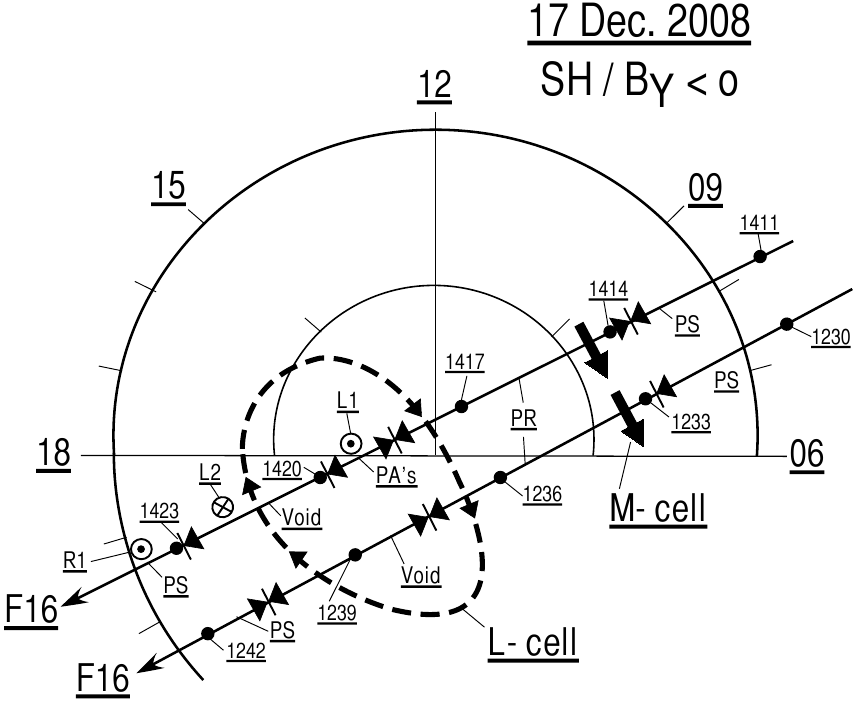
Fig. 3. Tracks of spacecraft DMSP F16 during the intervals 12:30–12:42 and 14:11–14:23UT plotted in MLT/MLAT coordinates. Precipi- tation (PS; PR; PAs; void) and Birkeland current (L1; L2; R1) regimes along the tracks are indicated. Cross-track ion drifts in the merging (antisunward; dawn side) and lobe (sunward; dusk side) convection cells are also marked. A lobe cell circulation which is consistent with the satellite observations has been schematically indicated by the dashed